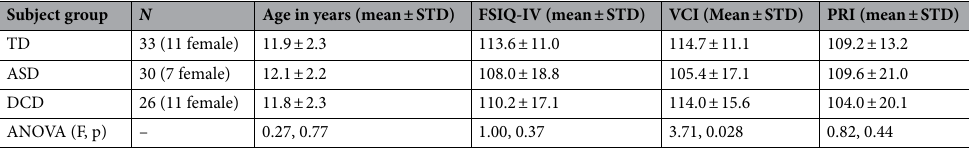
Table 6. TD, ASD, and DCD subject groups. Subject groups were matched for age, and IQ; F-statistic and p-value are reported for one-way ANOVAs comparing the three group means for each measure.